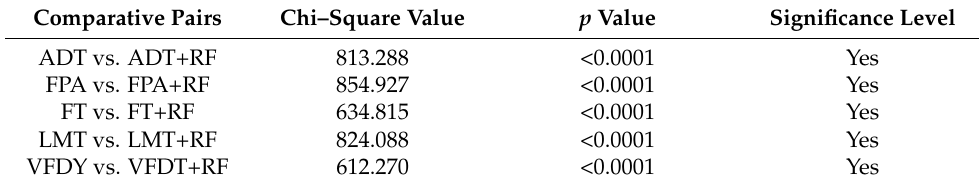
Figure 5. The ROC curves for all the methods using the verification set. ( a ) DTs and ( b ) RF-based ensemble methods. Table 5. Chi-square values and significant levels of all the methods.